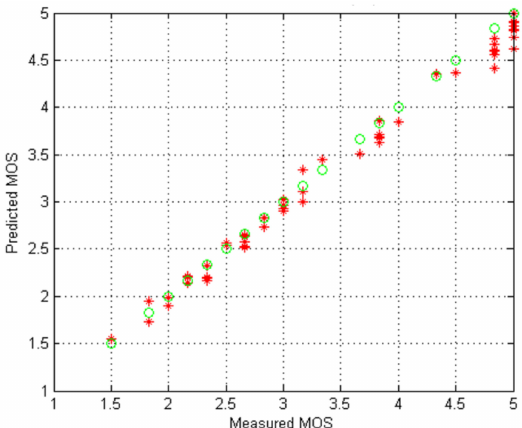
Figure 16. Subjective MOS vs. predicted MOS for laptop.